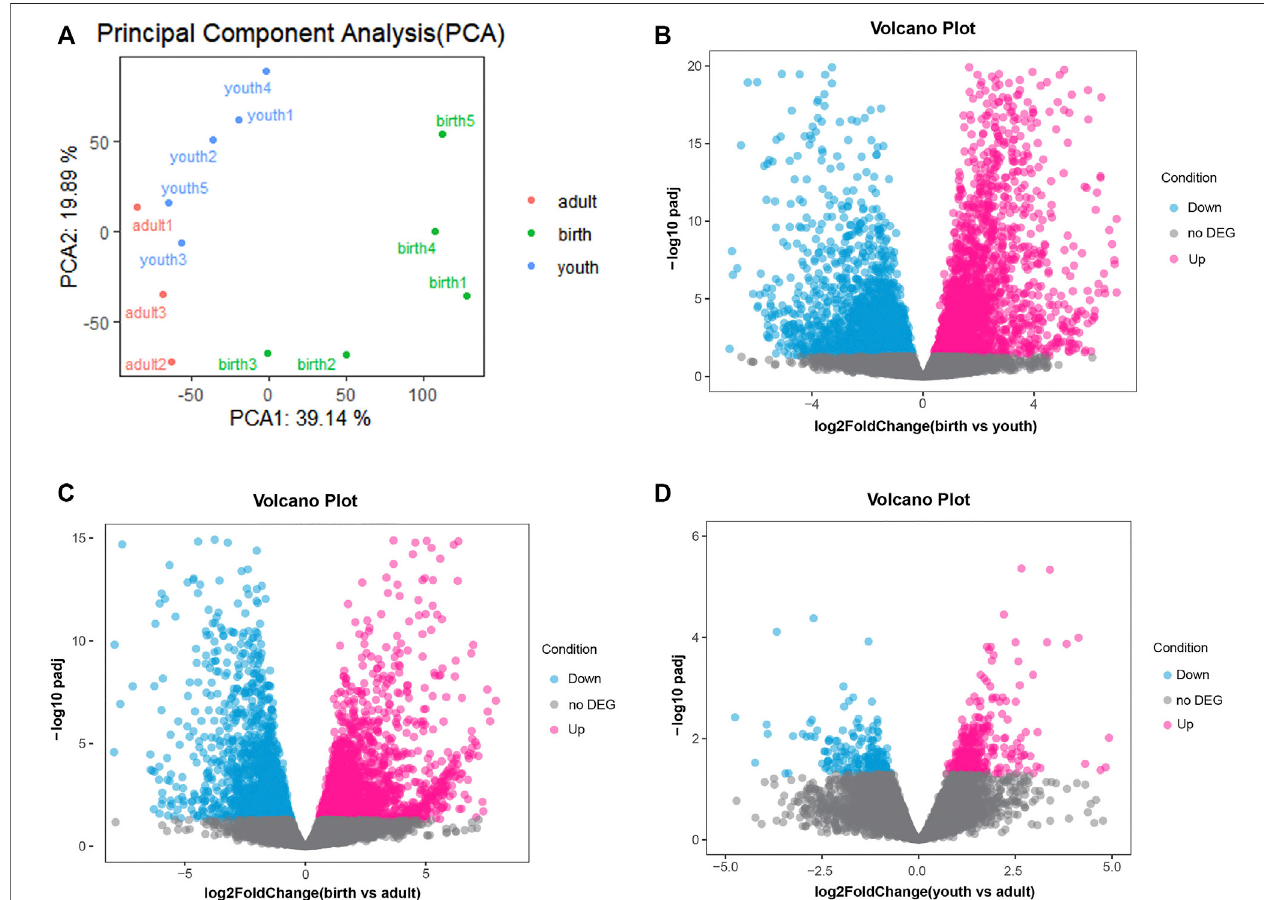
FIGURE1|(A) PCA ofthe identi fi edgenes,the red,green and bluedots represent samplesofadult, birth and youthperiods. (B) Volcano plotofdifferentialgenes, volcano plot for DEGs in rumen tissue comparing birth period and youth period. (C) Volcano plot for DEGs in rumen tissue comparing birth period and adult period. (D) Volcano plot for DEGs in rumen tissue comparing youth period and adult period, red and blue dots represent up/down-regulated DEGs, respectively. The gray dots represent not